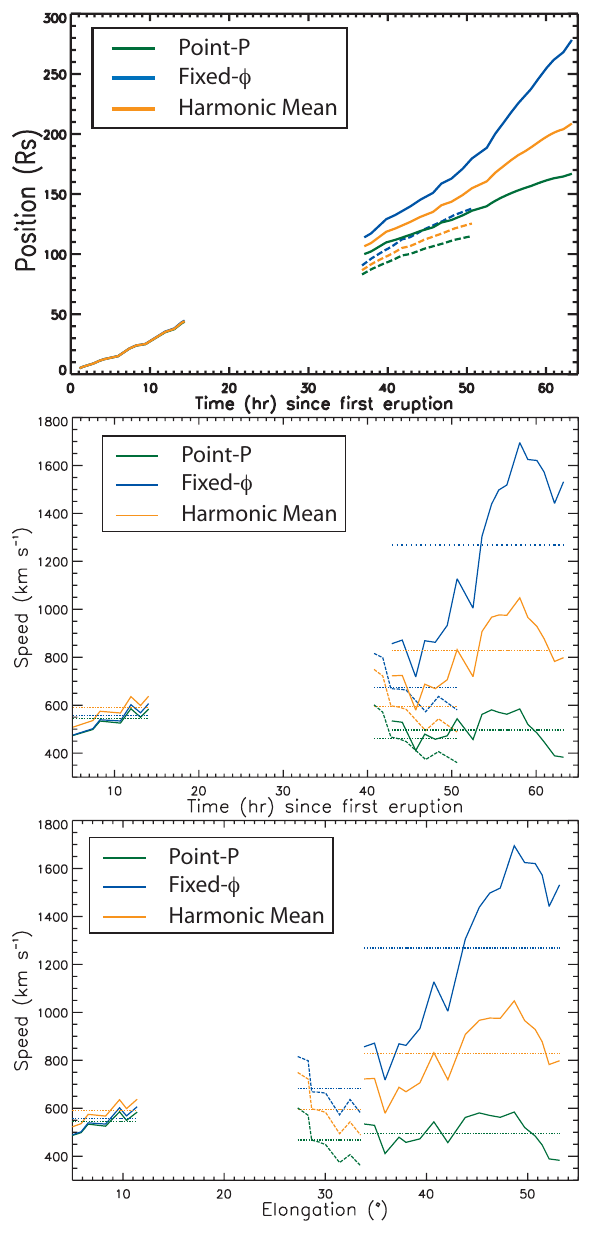
Fig. 3. Position (top) and speed (middle and bottom) of the two fronts at PA 69 according to the three methods. The errors are typi- cally 1.5% for the position and 15% for the speed. The averages are shown with dotted lines and the second front with dashed lines.